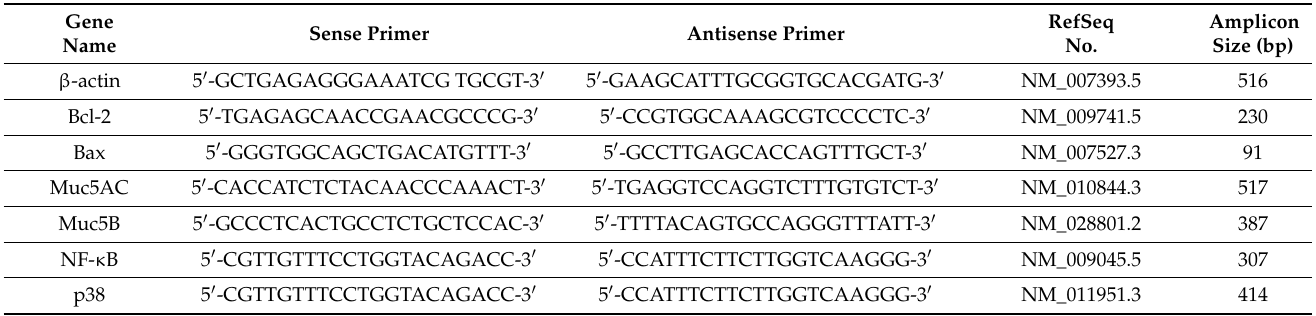
Table 1. Primer sequences used in the present